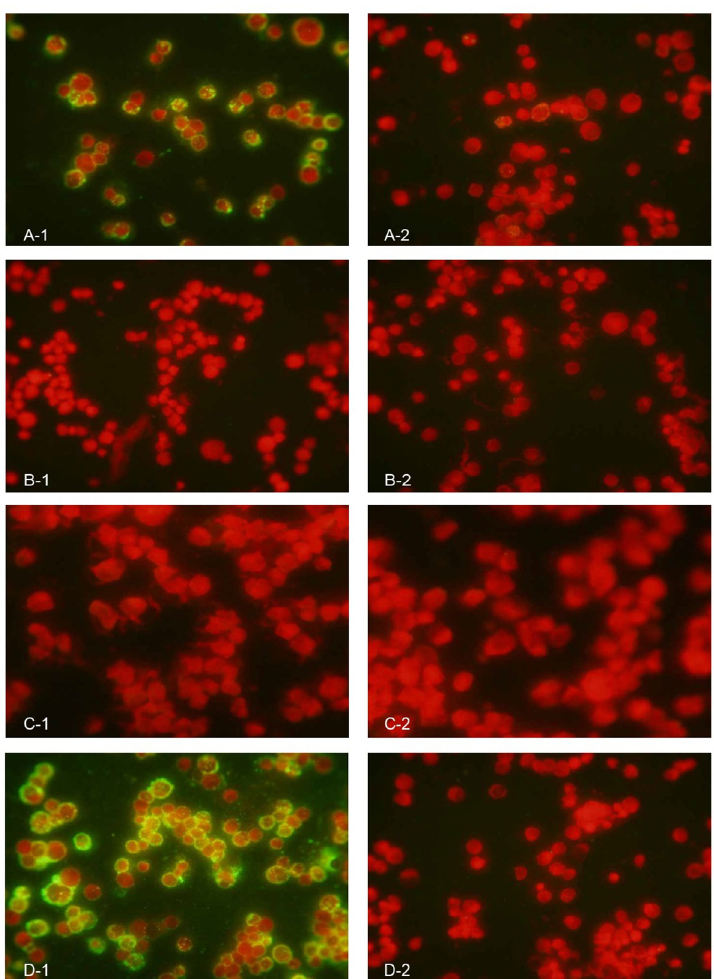
Fig 2. Detection of severe fever with thrombocytopenia syndrome virus (SFTSV) antibodies in serum samples from animals fed by SFTSV-infected ticks through immunofluorescence assay. A) Serum samples from the mouse bitten by I. sinensis ticks reacting with SFTSV-infected Vero E6 cells (A-1 SFTSV group, A-2 Control group). B) Serum samples from the mouse bitten by I. persulcatus ticks reacting with SFTSV-infected Vero E6 cells (B-1 SFTSV group, B-2 Control group). C) Serum samples from the rabbit bitten by D. silvarum ticks reacting with SFTSV-infected Vero E6 cells (C-1 SFTSV group, C-2 Control group). D) Serum samples from the rabbit bitten by H. longicornis